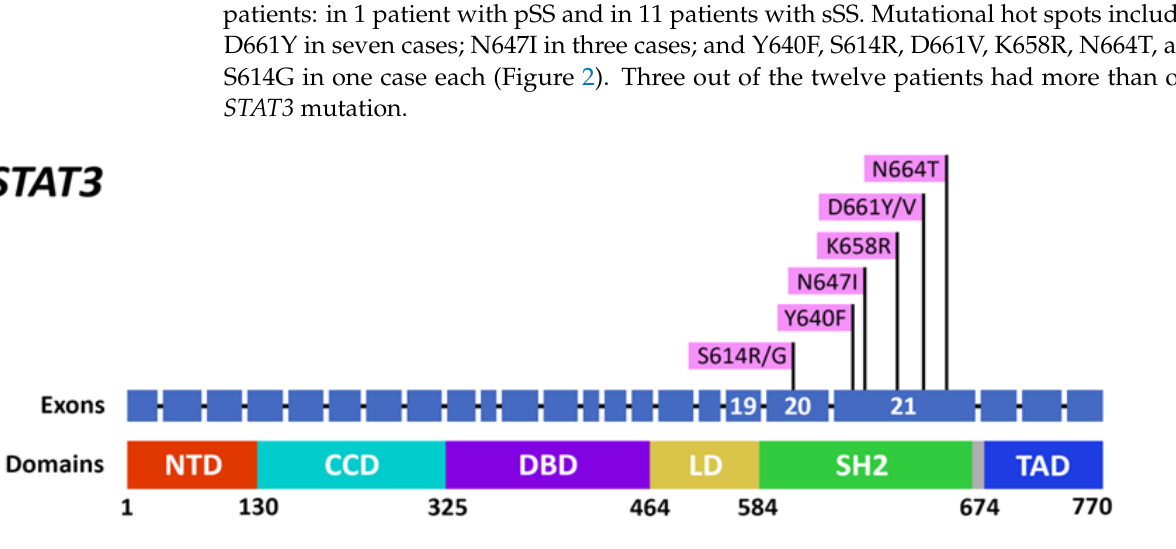
Figure 2. Distribution of STAT3 mutations in the SH2 domain detected within patients with T-LGL leukemia and Sjögren syndrome.